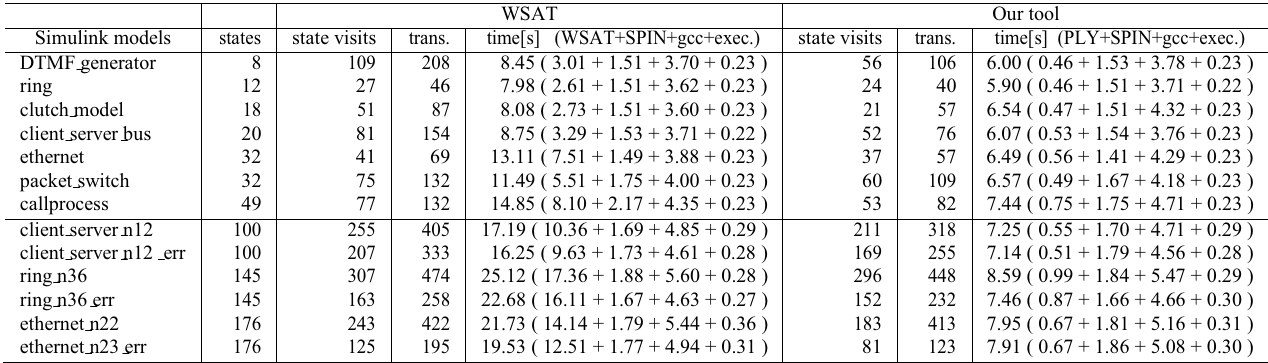
Table 4: Experimental results for checking liveness